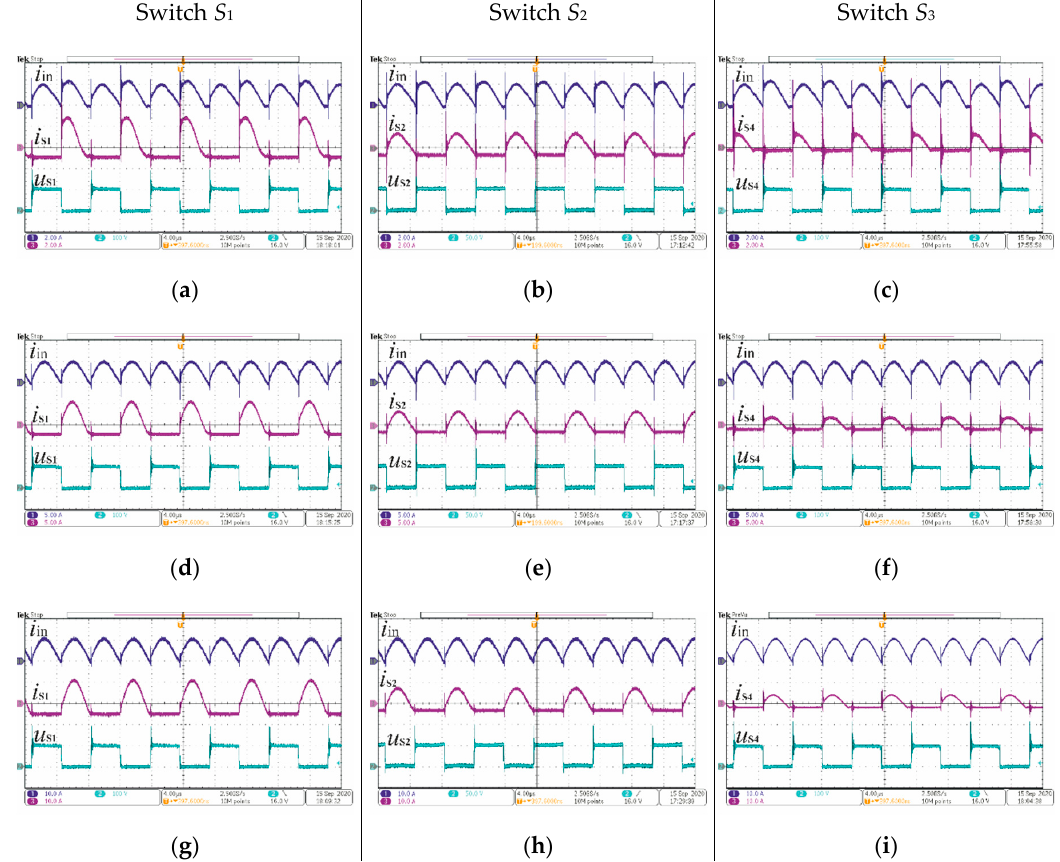
Figure 14. Waveforms of the input current as well as the currents and voltages across switches, during experimental test proceeded with different values of converter output power: ( a – c ) P out = 62 W, 2A/div, 100V/div, ( d – f ) P out = 146 W, 5A/div, 100V/div, ( g – i ) P out = 290 W, 10A/div, 100V/div. Switching strategy C5.